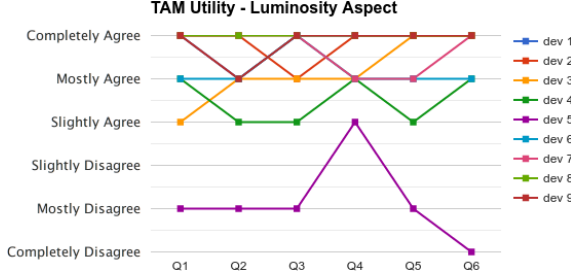
Fig. 10. T3 Speech - Perceived ease of use and usefulness.